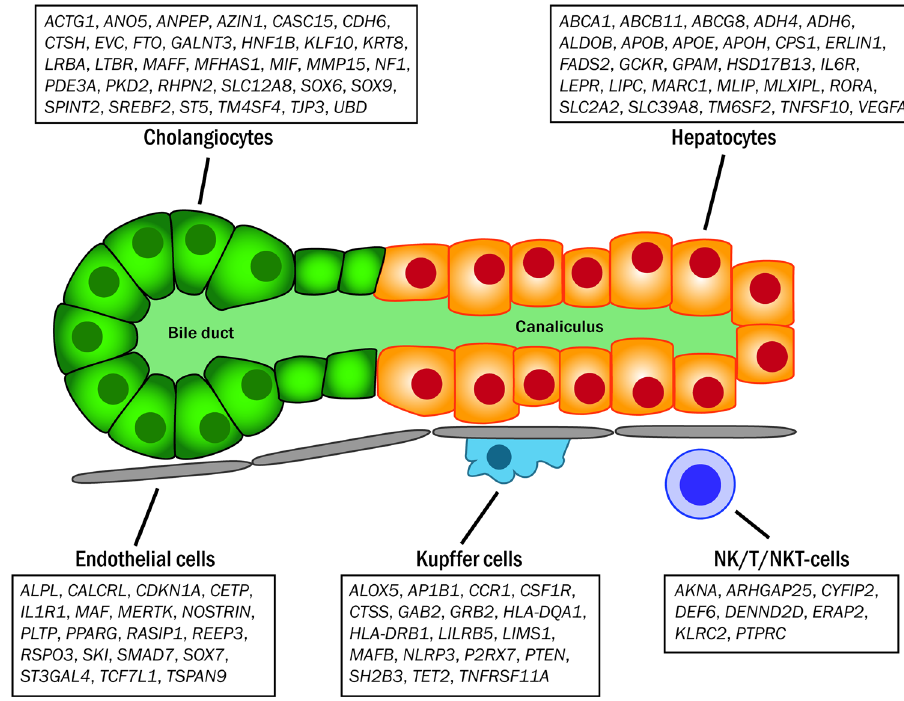
Fig. 7 Cell type-speci fi c expression of genes nearest to selected liver enzyme-associated genetic variants. Gene names appear in the boxes corresponding to the cell type in which they are speci fi cally